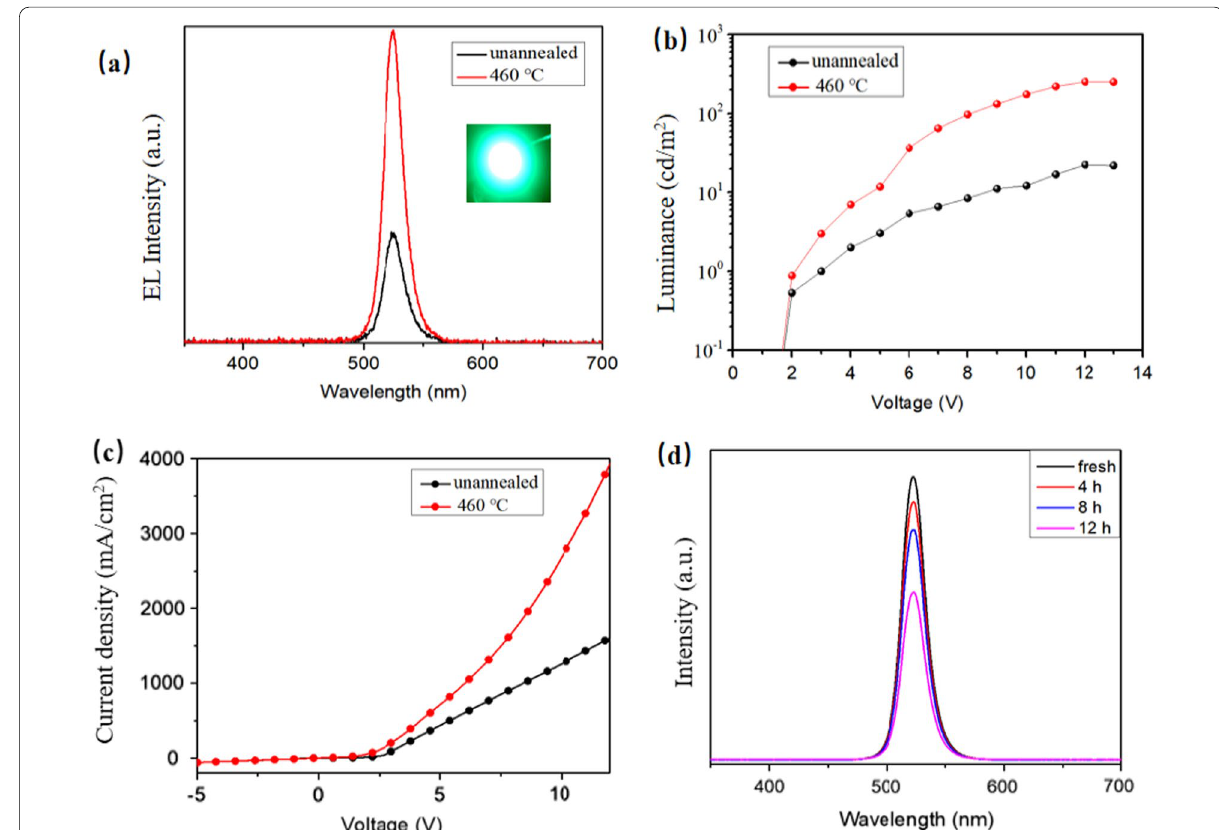
Fig. 12 a EL spectra, b luminance against voltage ( L – V ) curves, c current density against voltage ( J – V ) curves of PeLEDs, and d EL spectra acquired at different operating cycles under the same bias and measurement